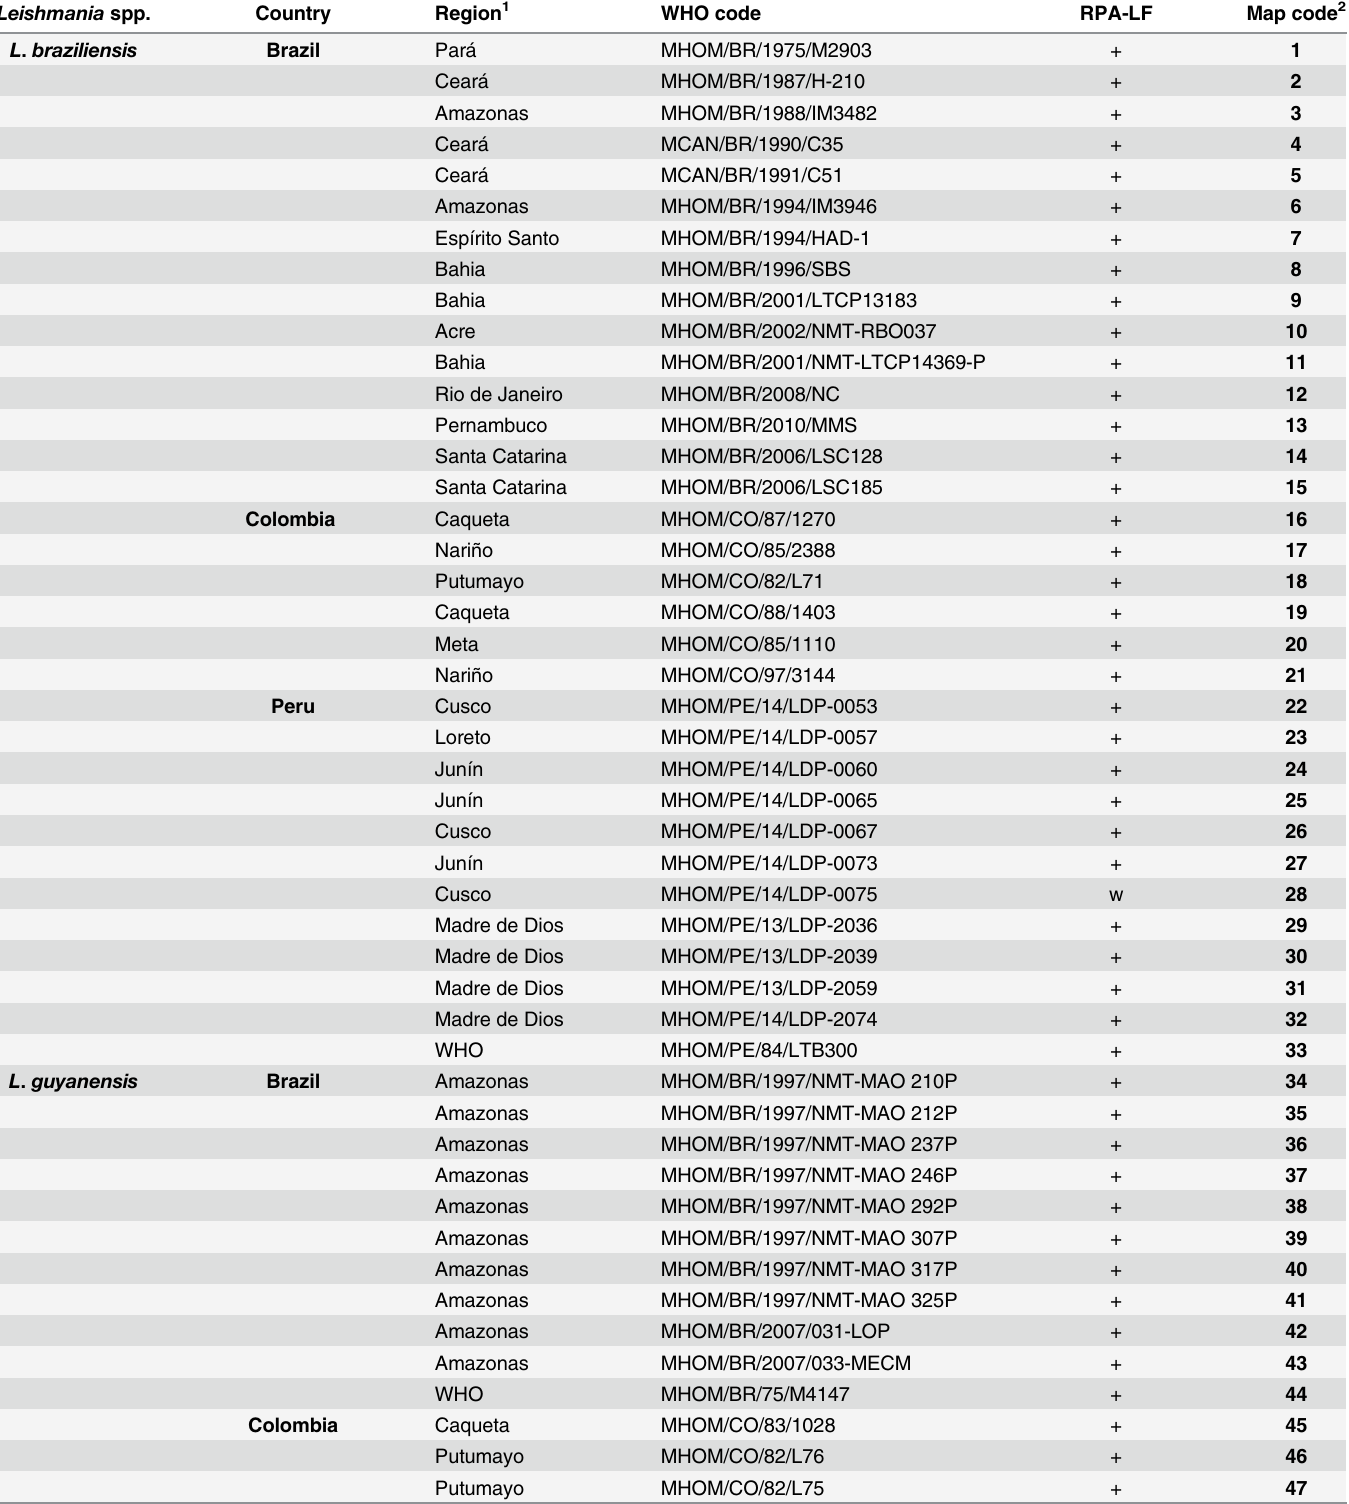
Table 1. RPA-LF detection of Leishmania Viannia species isolated from different countries in Latin America. Leishmania